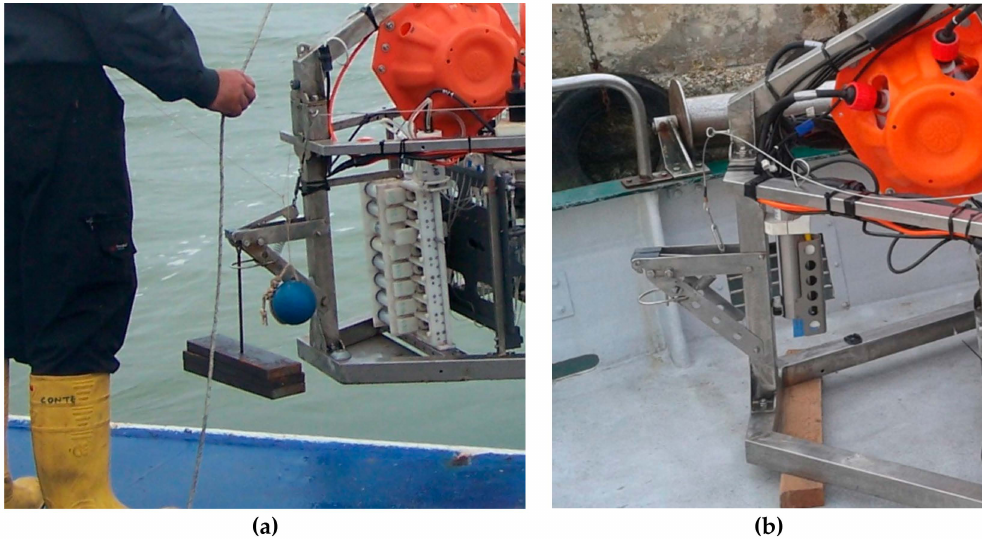
Figure 5. The three lever hooks in a locked ( a ) and unlocked ( b )